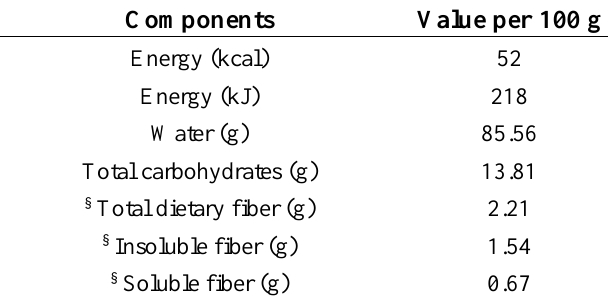
Table 1. Composition of apples ( Malus domestica ), raw with skin. USDA National Nutrient Database for Standard